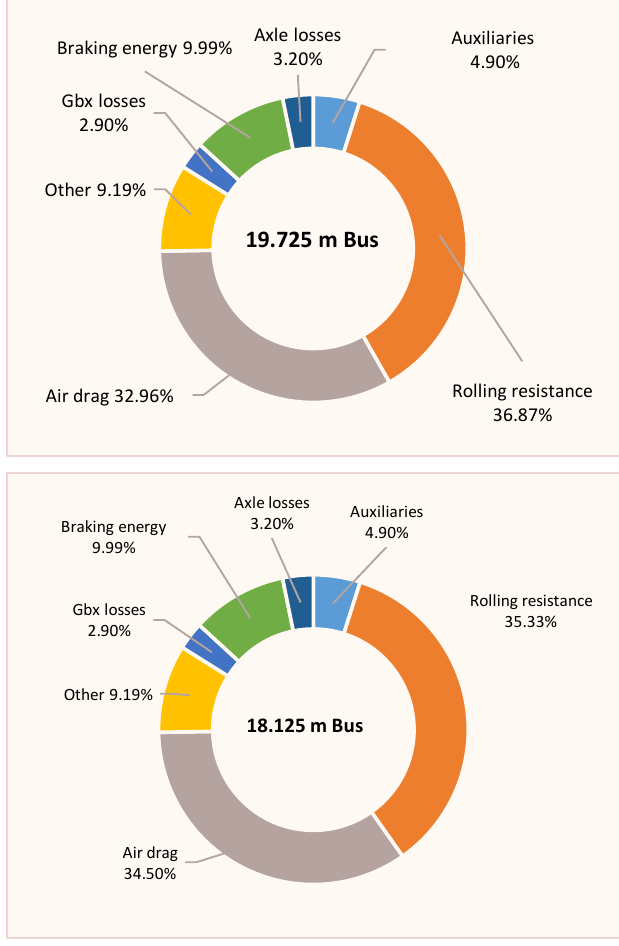
Fig. 5. Energy losses